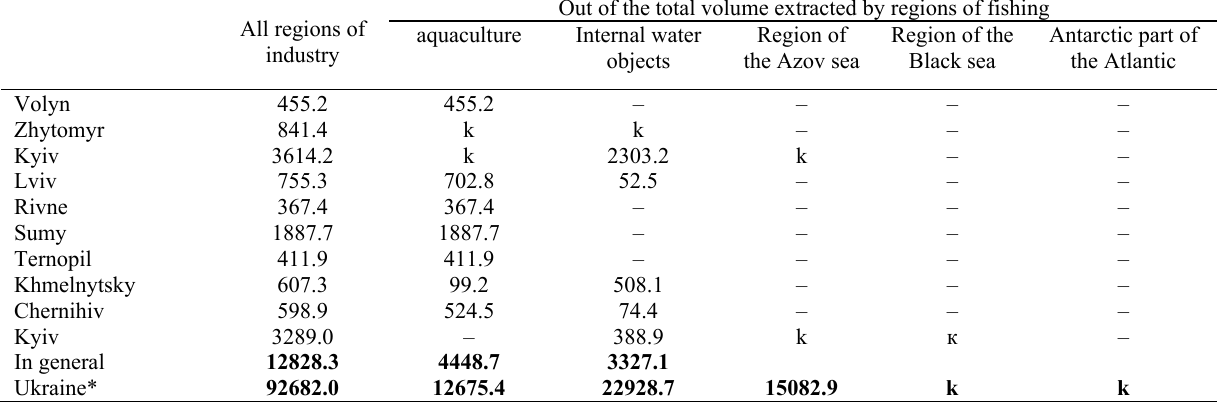
Total volume of harvested aquatic organisms in the III zone of aquaculture of Ukraine in 2019, t (according to the State Statis- tics of Ukraine) (Derzhavna sluzhba statistiki Ukrayini) Out of the total volume extracted by regions of fishing All regions of